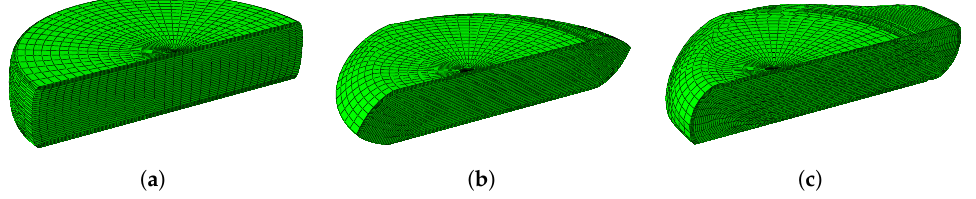
Figure 6. Meshed model at different horizontal deflections. ( a ) Initial state. ( b ) u h = 112.5% t r . ( c ) u h = 225% t r .